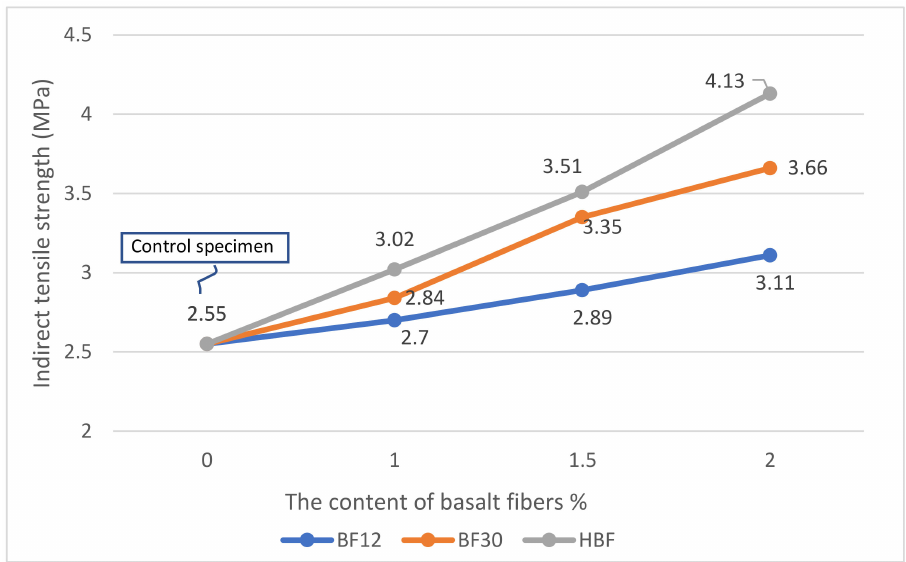
Figure 13. The indirect tensile strength variation for 12 mm, 30 mm, and hybrid BFs reinforced SCGC with different weight